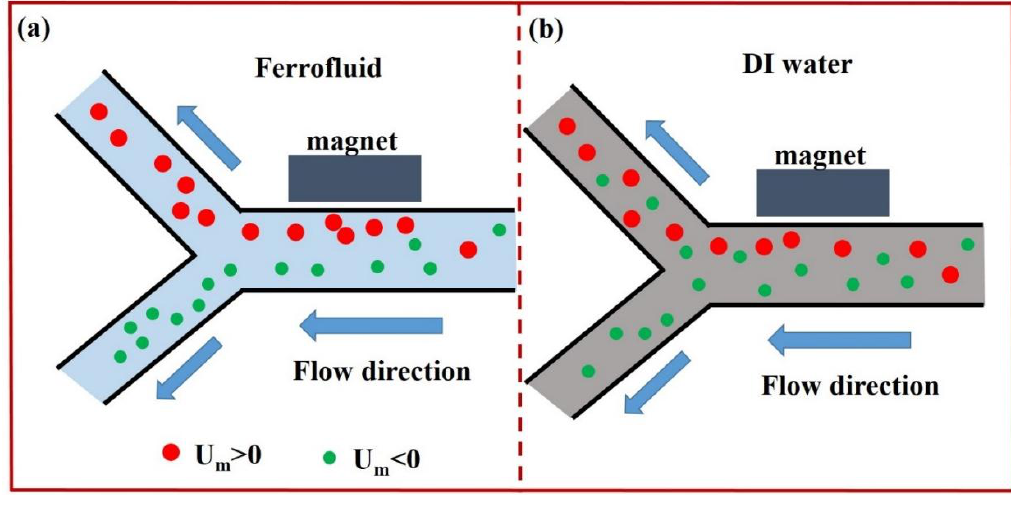
Figure 6. Schematics illustrating and comparing the separation mechanisms of magnetic and diamagnetic particles in ferrofluid and water 0 and U < 0 indicate the positive and negative magnetophoresis experienced by the magnetic m and diamagnetic particles,